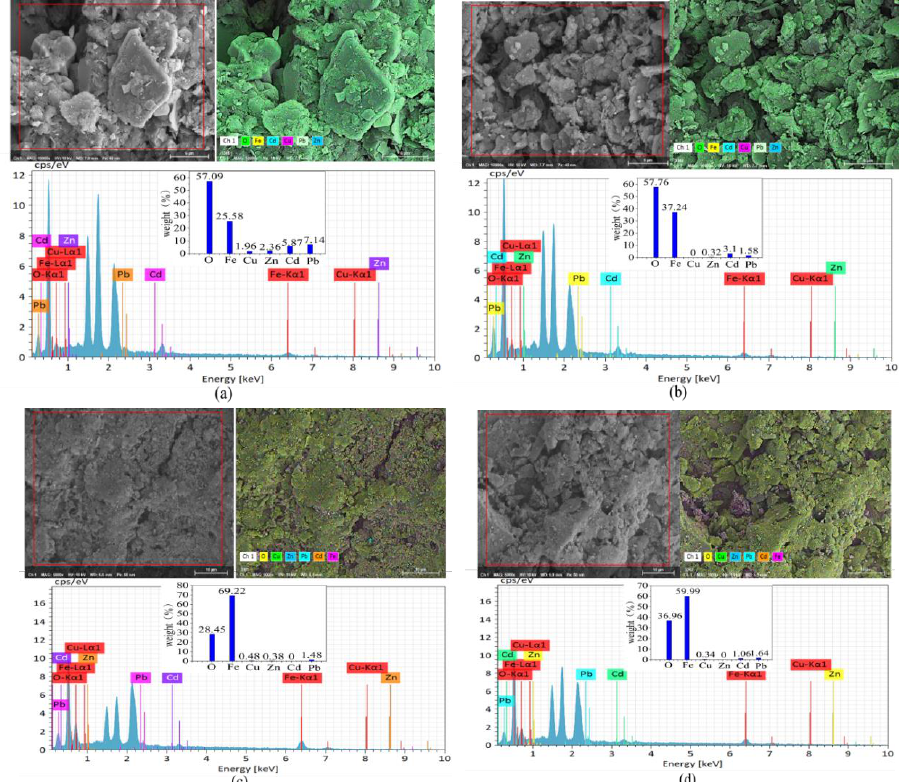
Figure 7. Mapping and EDS analyses of nZVI after reaction. ( a ) 100 mg/kg S-nZVI; ( b ) 100 mg/kg S-nZVI+ AM; ( c ) 100 mg/kg B-nZVI; ( d ) 100 mg/kg B-nZVI+AM.